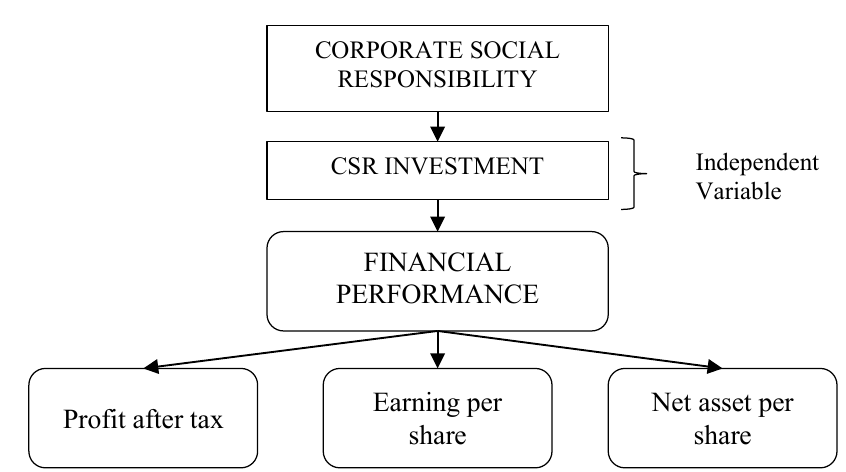
Fig. 1. Conceptual framework (Researchers’ diagrammatical representation of conceptual